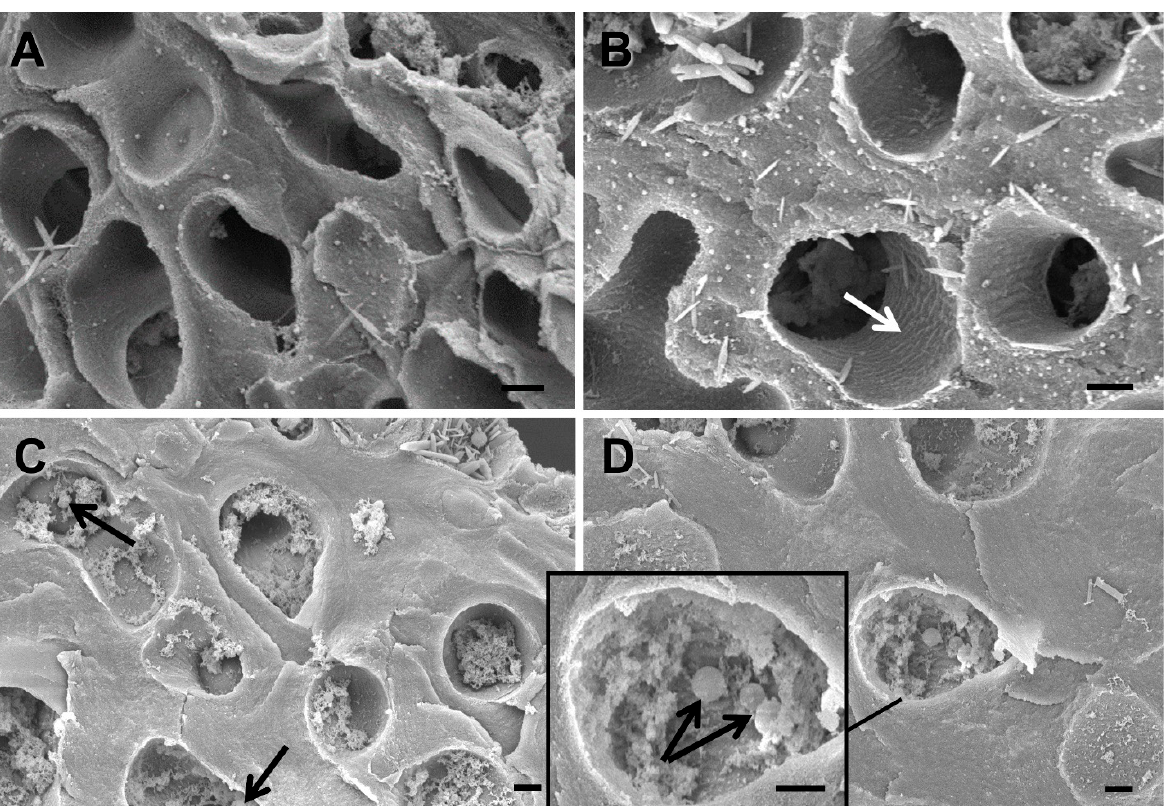
Figure 3. SEM images of cross sections from non-melanized ( A ), weakly melanized ( B ) and strongly melanized ( C , D ) Lobaria thalli. White arrow indicates the rough appearance of internal surface of lumens of fungal hyphae. Black arrows indicate spherical melanin-like granules. Bar = 1 μ m. The elemental composition in pale and strongly melanized thalli of L. pulmonaria was analyzed by EDX in three selected zones of the paraplectenchyma that form the